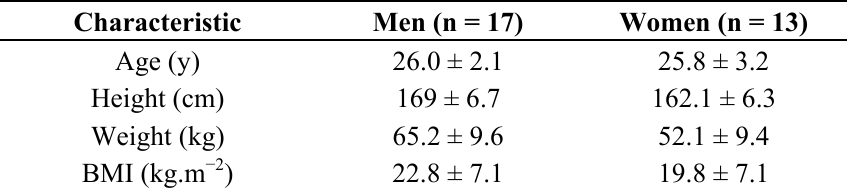
Table 1. Physical characteristics of subjects.